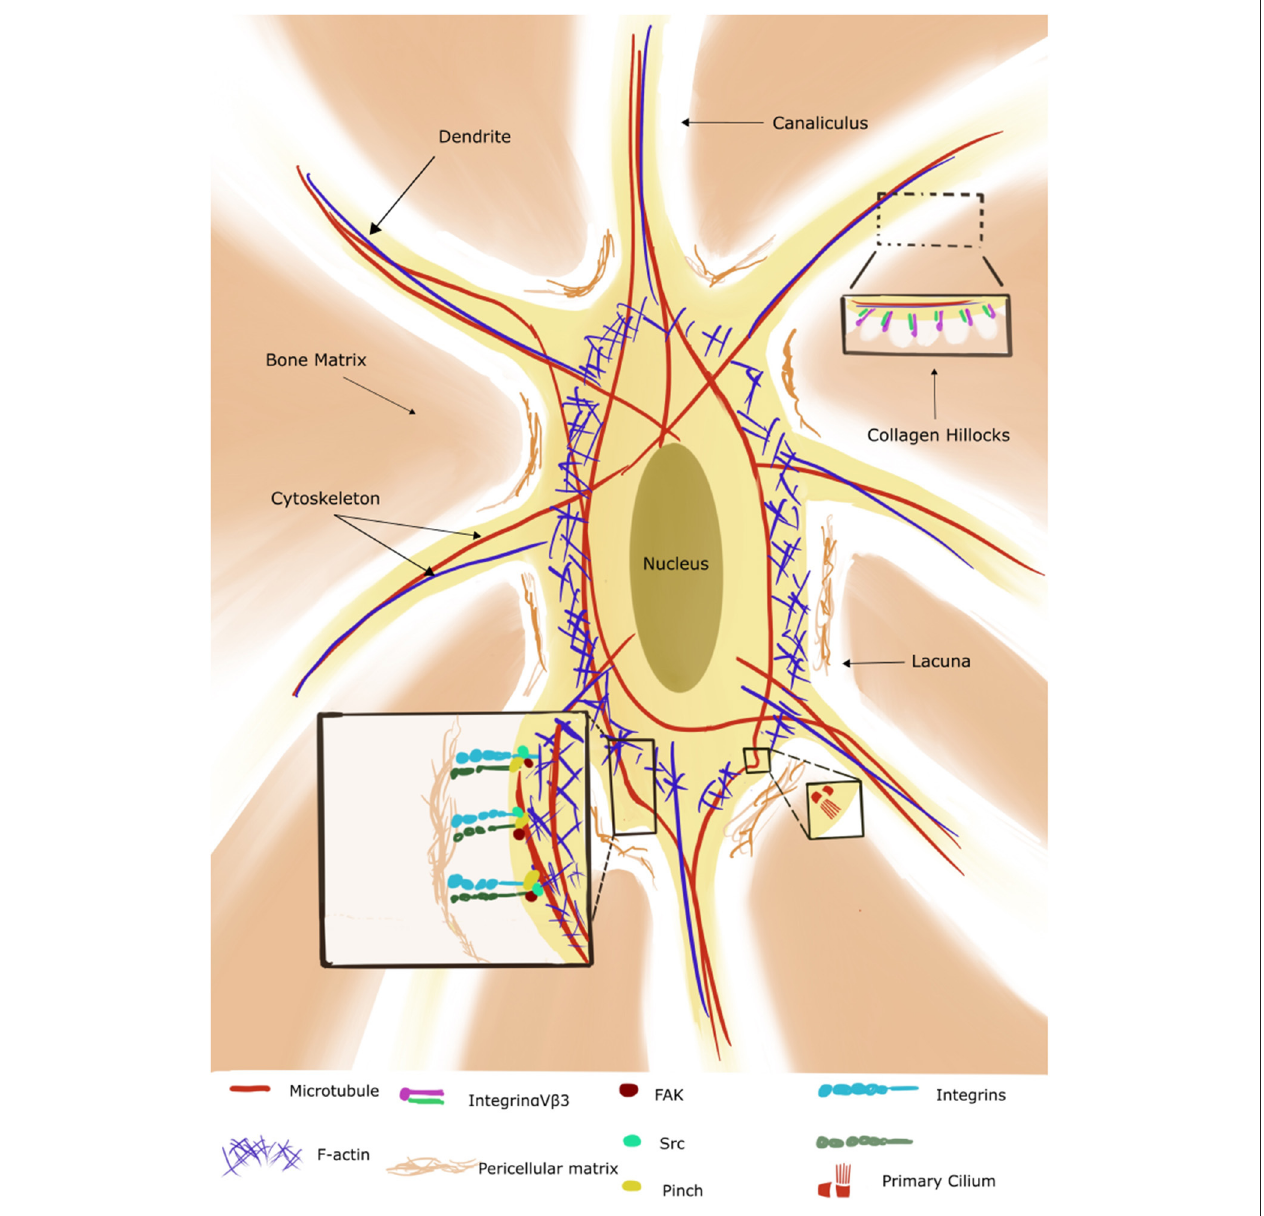
FIGURE 2 | Illustration of an osteocyte with its lacuno-canalicular system (adapted from Qin et al., 2020). The cytoskeleton consists of microtubules (red) which extend to the primary cilium, actin (blue) and intermediate filaments (not shown in the figure). The bone osteoid forms collagen hillocks at the canaliculi. Integrins are present on the cell body and dendrites/osteocyte processes and interact with the pericellular matrix and cytoskeleton via the focal adhesion components (only three shown for simplicity). (Reproduced with permission: